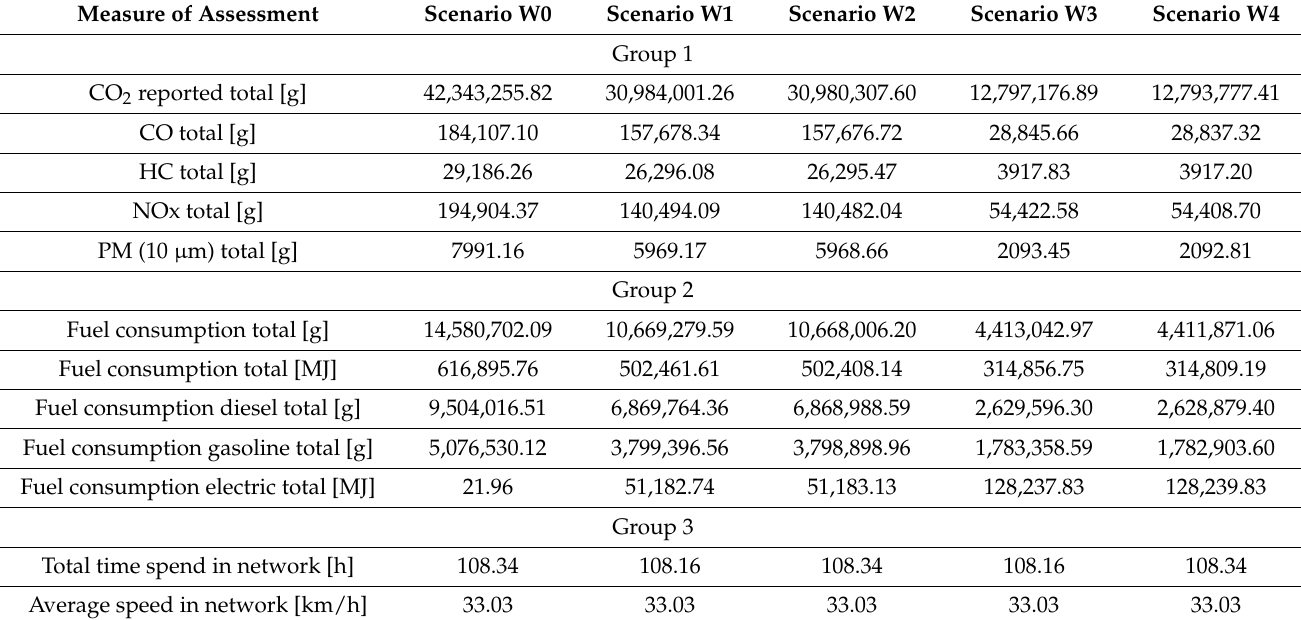
Table 5. The values of the measures for assessing the impact of the share of electric vehicles in traffic on the reduction of exhaust emissions for the reference scenario W0 and for the scenarios W1–W4—analysis for the whole